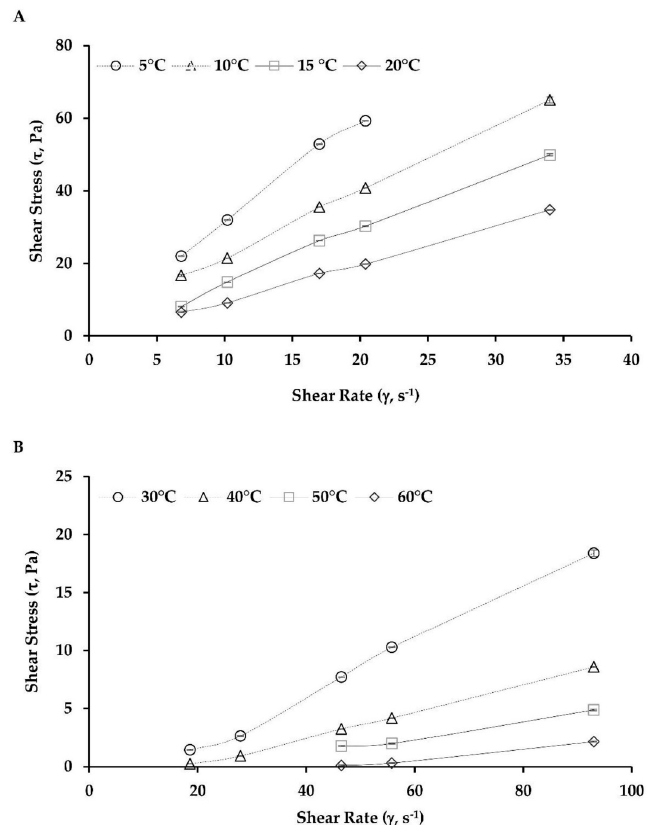
Figure 2. Rheogram flow curve of oleoresin at different temperatures with a relationship between shear stress ( τ ; Pa) and shear rate ( γ ; s –1 ). (A) Low temperatures from 5 to 20 °C (with spindle SC–21; n = 3) and (B) high temperatures from 30 to 60 °C (with spindle SC–27; n = 3).